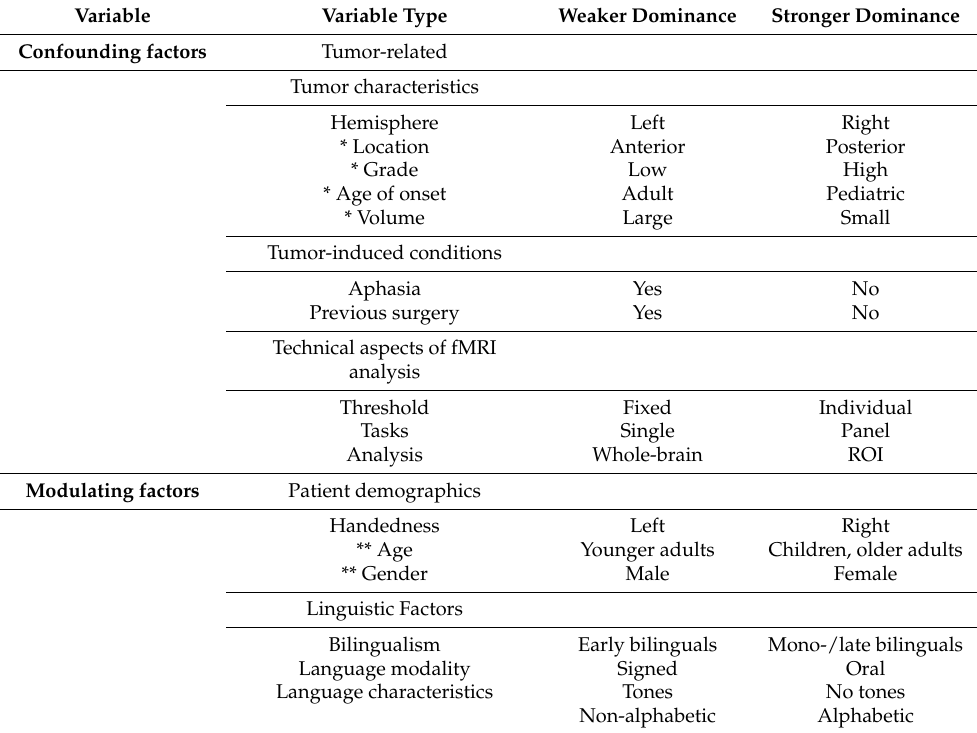
Table 2. Confounding and modulating factors affecting fMRI estimates of language dominance in patients with brain tumors. * in the language-dominant hemisphere; ** variables having only a subtle impact on fMRI language